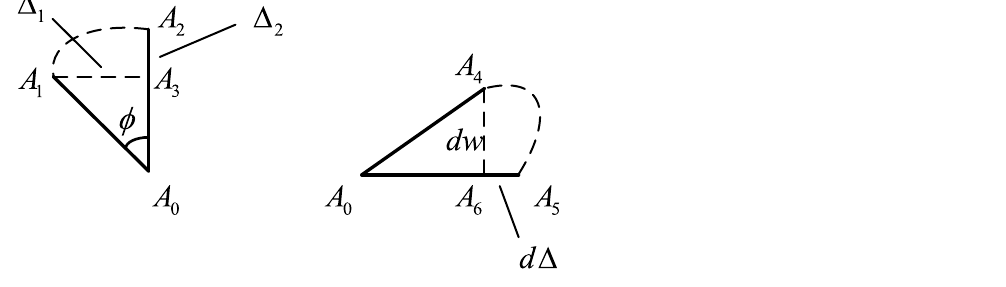
Figure 2. Deformation